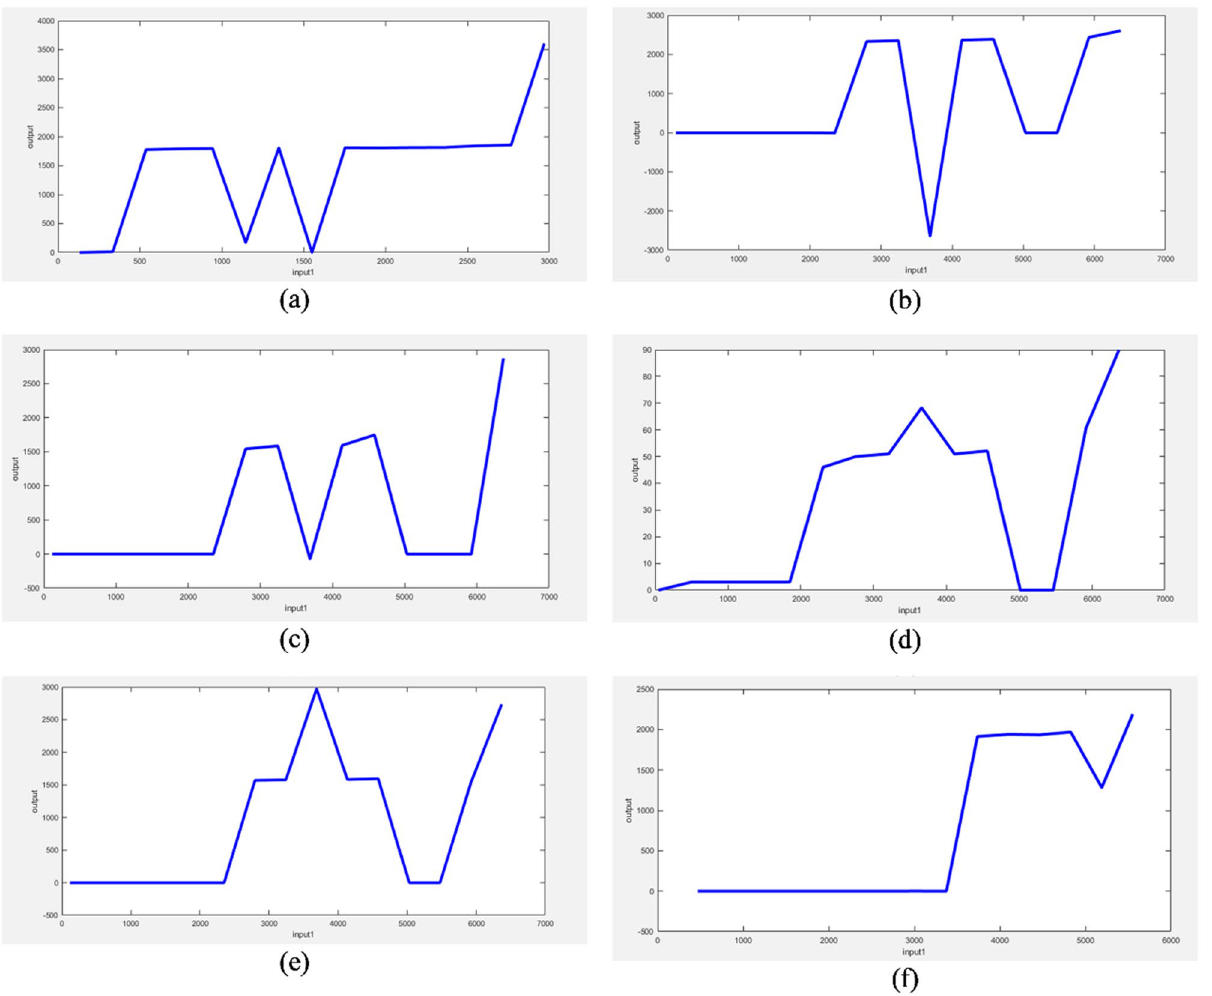
Figure 5. Post processing results of ANFIS ( a ) Iron, ( b ) Kettle, ( c ) Microwave, ( d ) Oven, ( e ) Toaster, ( f ) Vacuum Cleaner.